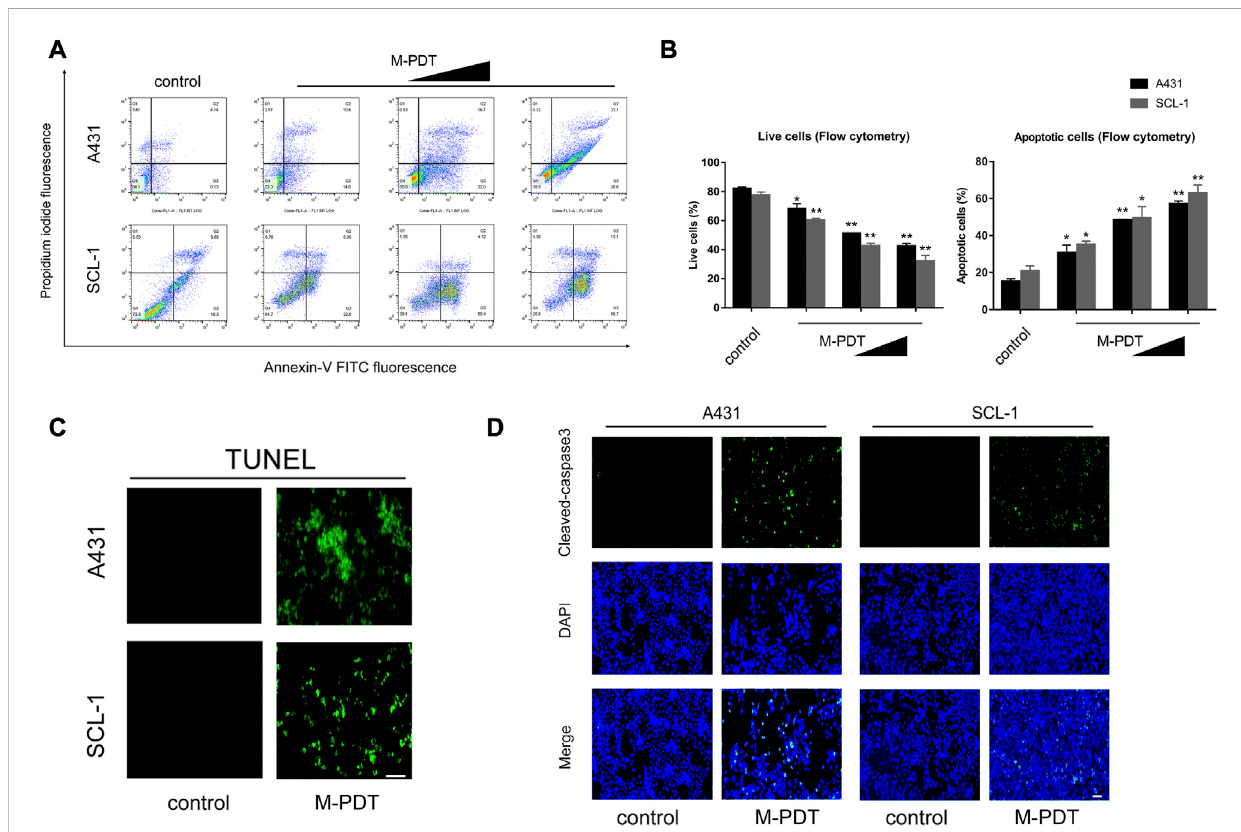
FIGURE 1 M-PDT induces cSCC cell viability suppression (A) The percentages of live and apoptotic cells were measured by FACS using annexin-V-FITC/PI staining. (B) Live cells and apoptotic cells in (A) were calculated. (C) TUNEL staining of cSCC cells. (D) After 24 h of M-PDT treatment, immuno fl uorescence of Cleaved-caspase 3 was detected. The light dose of M-PDT was 54 J/cm 2 for A431 cells, and 21.6 J/cm 2 for SCL-1 cells (C, D) . * p < 0.05, ** p < 0.01, difference vs. control group; the scale bar (C, D) is 100 μ m. n =